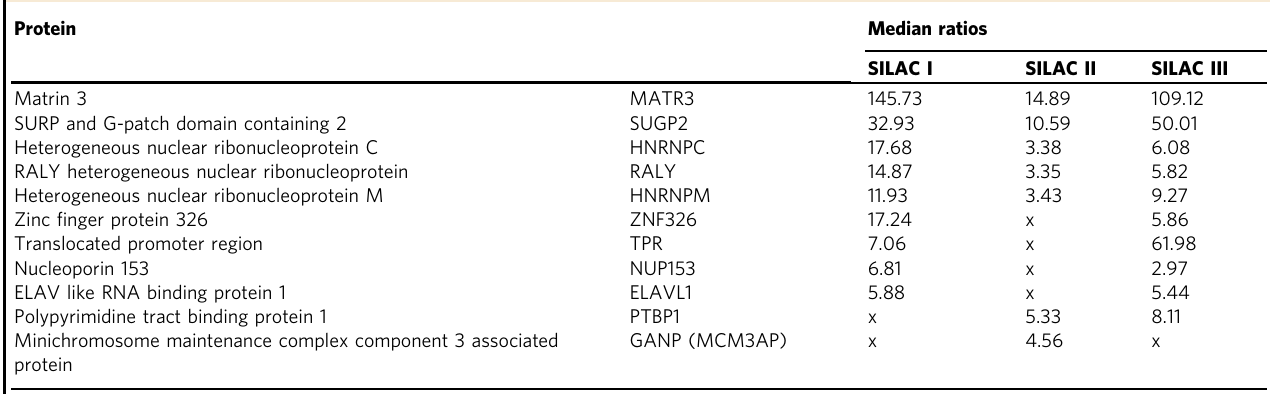
Table 1 Tpr interacts with proteins involved in RNA metabolism.